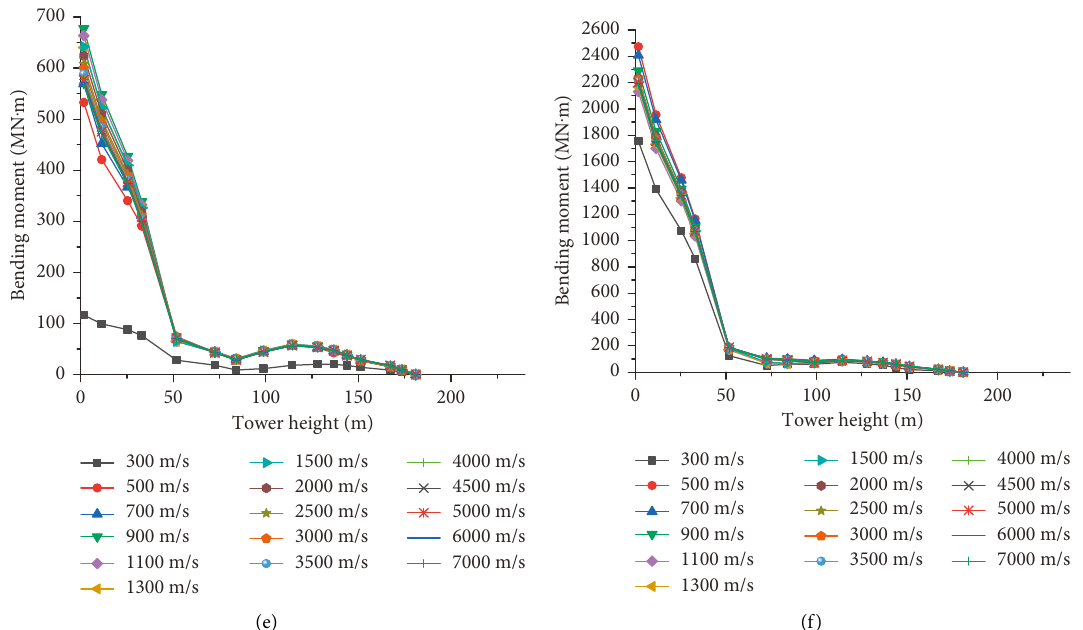
Figure 12: Distribution of maximum displacement and maximum bending moment along with the tower height under three kinds of seismic waves with different apparent wave velocities. (a) 1979 James RD E1 Centro 220 Deg seismic wave, (b) 1994 Northridge Sylmar County Hosp 90 Deg seismic wave, (c) the artificial wave, (d) 1979 James RD E1 Centro 220 Deg seismic wave, (e) 1994 Northridge Sylmar County Hosp 90 Deg seismic wave, and (f) the artificial